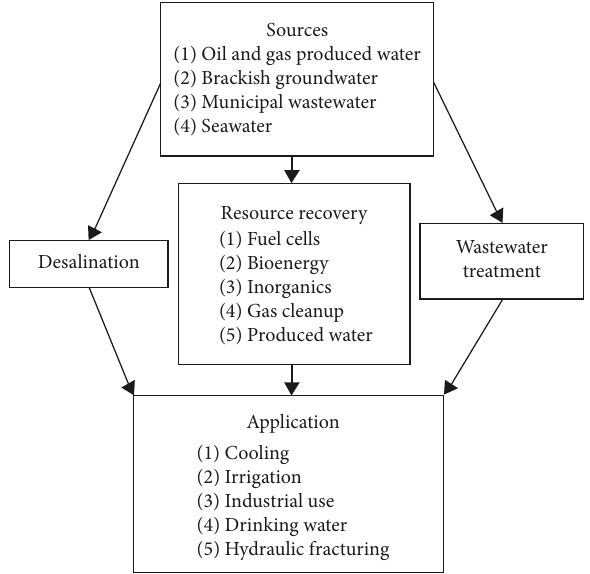
Figure 8: Role of water in the energy